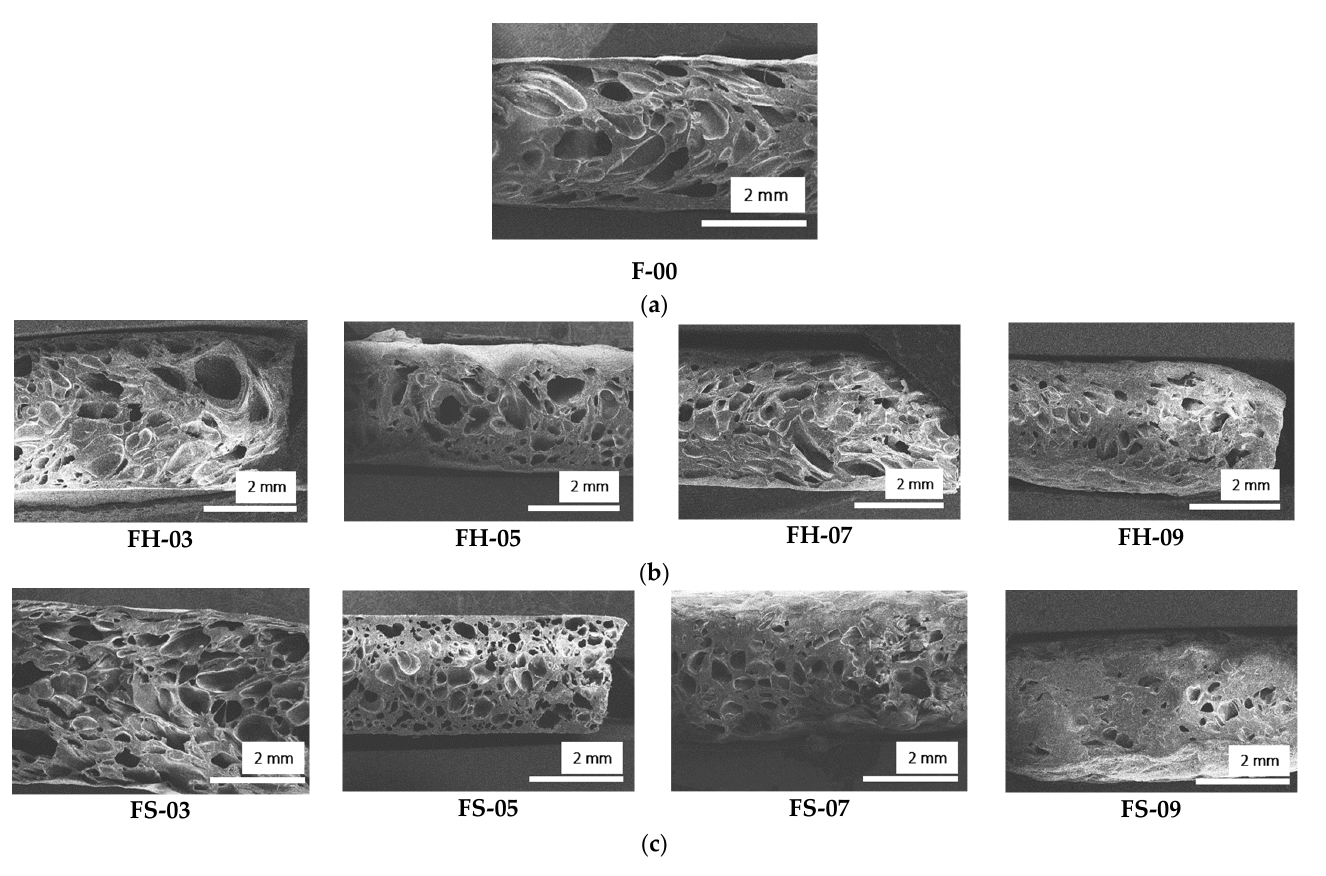
Figure 6. SEM images of ( a ) unfilled NRF; ( b ) silica–lignin hybrid-filled NRF; and ( c ) silica-filled NRF.